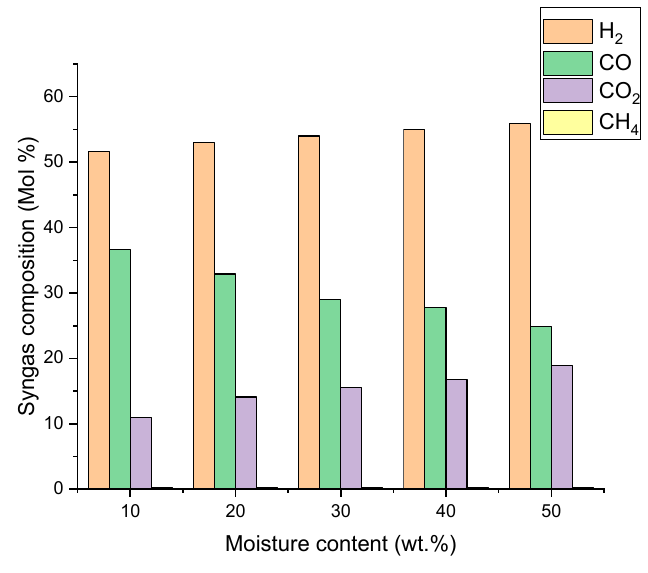
Appl. Sci. 2020 , 10 , x FOR PEER REVIEW Figure 4. E ff ect of pyrolysis oil moisture content on syngas composition. Figure 4. Effect of pyrolysis oil moisture content on syngas composition.